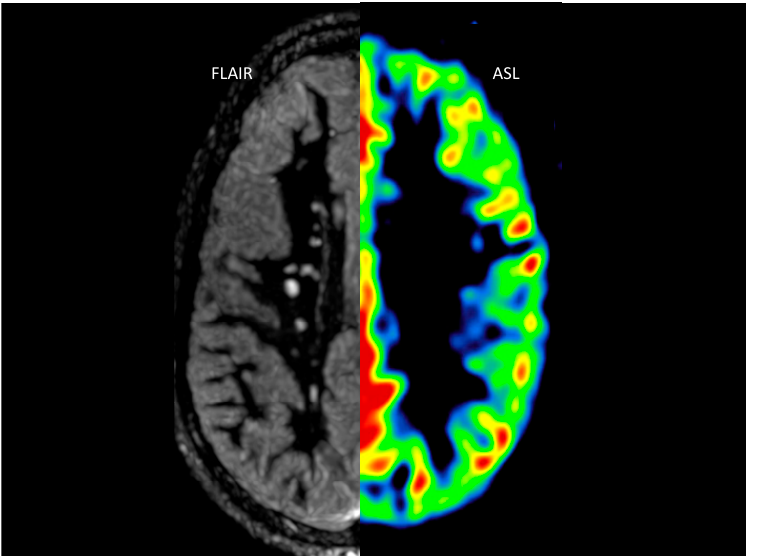
Figure 1 . Combination of FLAIR sequence ( left ) for assessment of white-ma tt er lesions and ASL Figure 1. Combination of FLAIR sequence ( left ) for assessment of white-matter lesions and ASL perfusion sequence ( right ) for quanti fi cation of cerebral cortical fl ow. perfusion sequence ( right ) for quantification of cerebral cortical